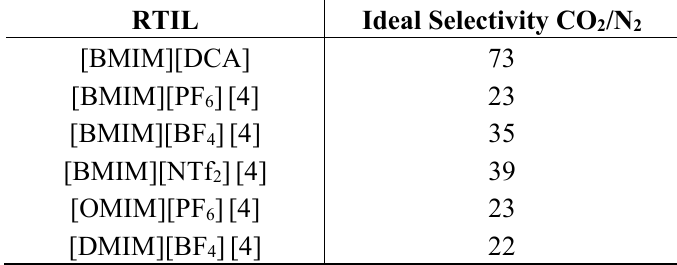
Table 3. Ideal selectivities obtained in this and in a previous work [4].